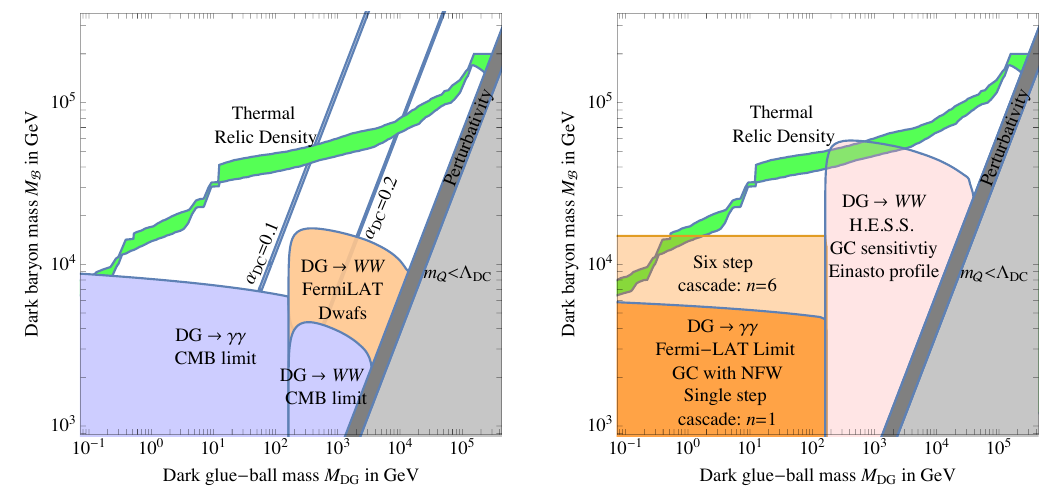
Figure 7 . Left: indirect detection limits on dark matter annihilation. Dwarf and CMB bounds (with small astrophysical uncertainties) are compared to cross section values for dark matter anni- hilation, which we estimate to be dominated by a recombination reaction of two dark baryons at low velocities. M is the mass of the DM baryon and M is the glue-ball mass. Two regimes are DG B clearly distinguished in the (cid:12)gure, they correspond to either dominant annihilations of glue-balls into WW (for M > M W ) and to dominant annihilations into (cid:13)(cid:13) (for M < M W ). The green DG DG bands show the region where the known DM density is obtained thermally. Right: the sensitivities of Galactic Center observations are considered and the most optimistic DM abundances for indirect detection at the core of the galactic DM pro(cid:12)le are